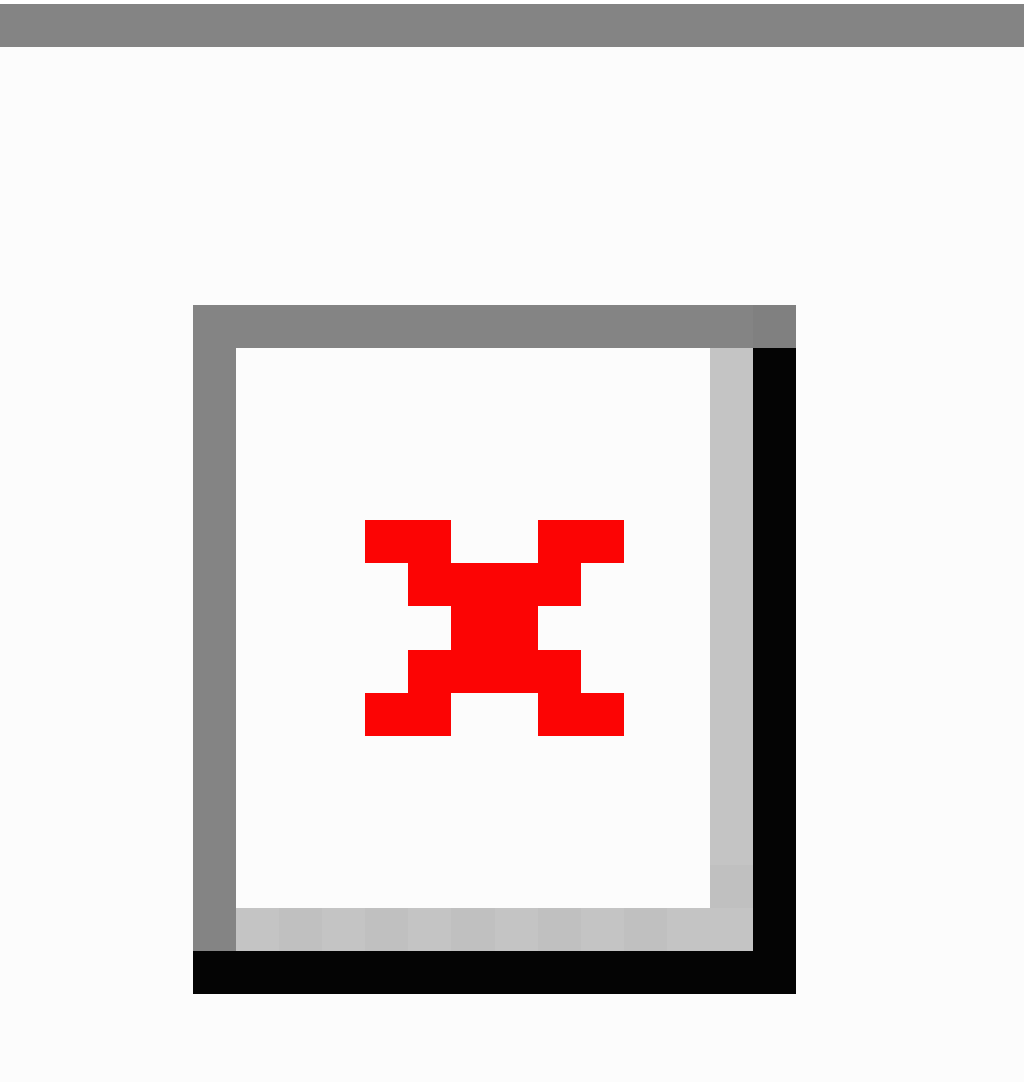
Figure 1. Routine data sharing under the Health Insurance Portability and Accountability Act of 1996 (HIPAA). EHR: electronic health record; PHI: protected health